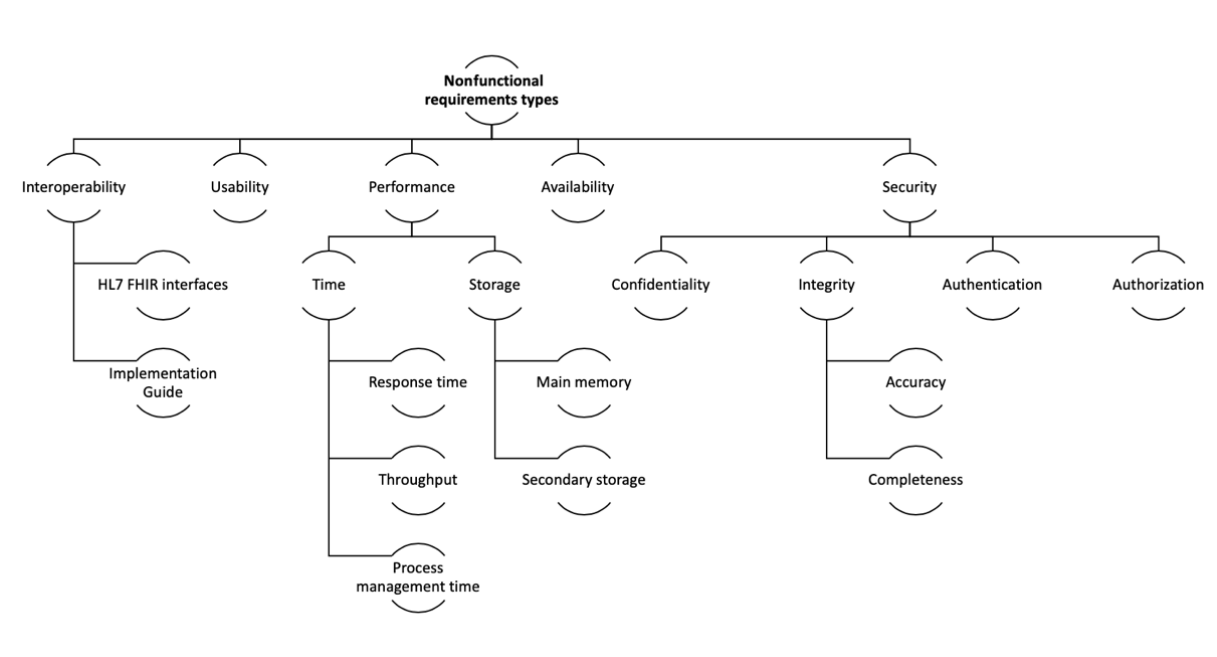
Figure 3. Nonfunctional requirements types for interoperable development. Catalog of nonfunctional requirements obtained from Wiegers (2005) and adapted for the interoperable platform to report polymerase chain reaction SARS-CoV-2 tests. FHIR: Fast Healthcare Interoperability Resources; HL7: Health Level